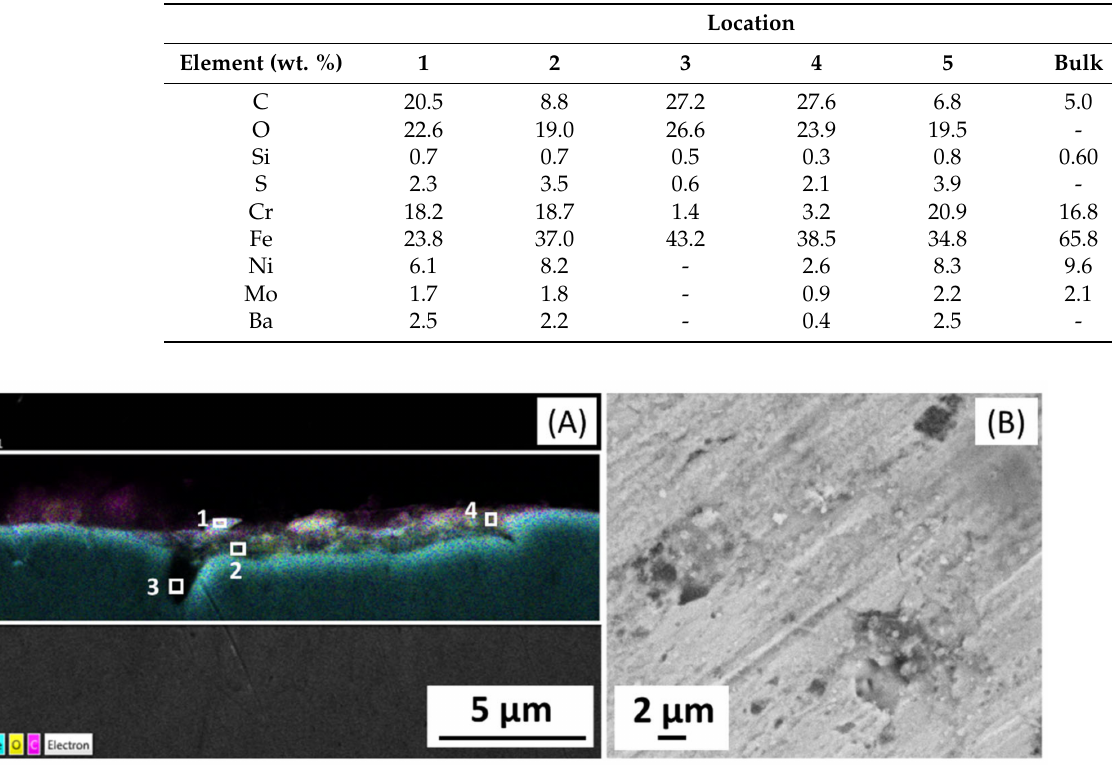
Figure 10. EDX elemental analysis of 316L after exposure in Chaunoy. ( A ): Cross-sectional elemental mapping of a surface defect, where locations marked for EDX elemental analysis are shown. Location 3 is inside the small surface defect, while locations 1, 2 and 4 are corrosion deposits around the defect. The colour map shows the relative elemental composition of Ni, Cr, Fe, O and C in the image. ( B ): Topography image of the surface defect by